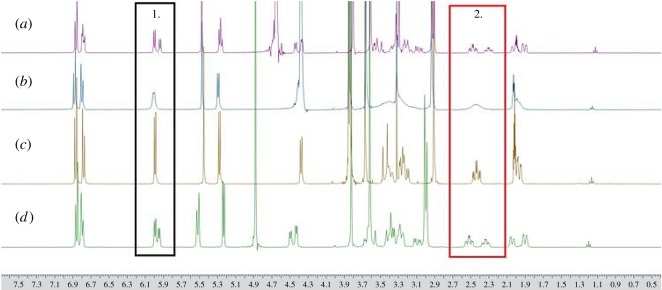
1H NMR spectra for thebaine in (a) D2O : CD3CN ratio 80 : 20 (v/v), (b) D2O : CD3CN ratio 50 : 50 (v/v), (c) D2O : CD3CN ratio 20 : 80 (v/v), (d) 100% D2O. All solutions contain 1% CD3COOD. X-axis units are ppm.